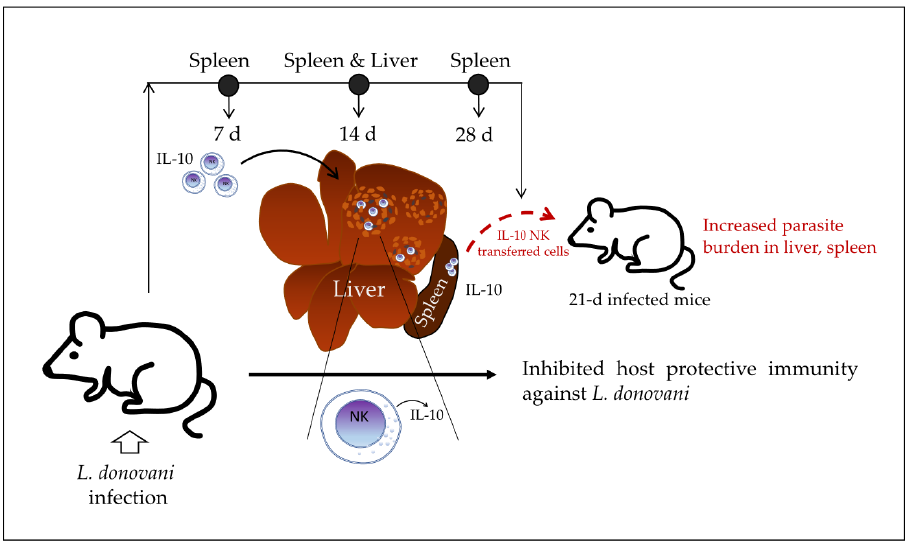
Figure 3. Proposed model of the role of IL-10-producing NK cells in visceral leishmaniasis. Splenic NK cells produce IL- 10 from an early stage of infection (7 days post-infection) through late stages (14 – 28 days post-infection) with L. donovani . IL-10-producing NK cells migrate into liver granulomas and spleen (14 days post-infection) and become the main source of IL-10 (14 days and 28 days post-infection) in both organs. IL-10-producing NK cells at late stages (28 days post-infection) induce an increased parasite burden in the liver and spleen of 21-day infected recipient mice when they are transferred, suggesting that they inhibit host protective immunity against L. donovani . L. donovani — Leishmania donovani ; d — days.